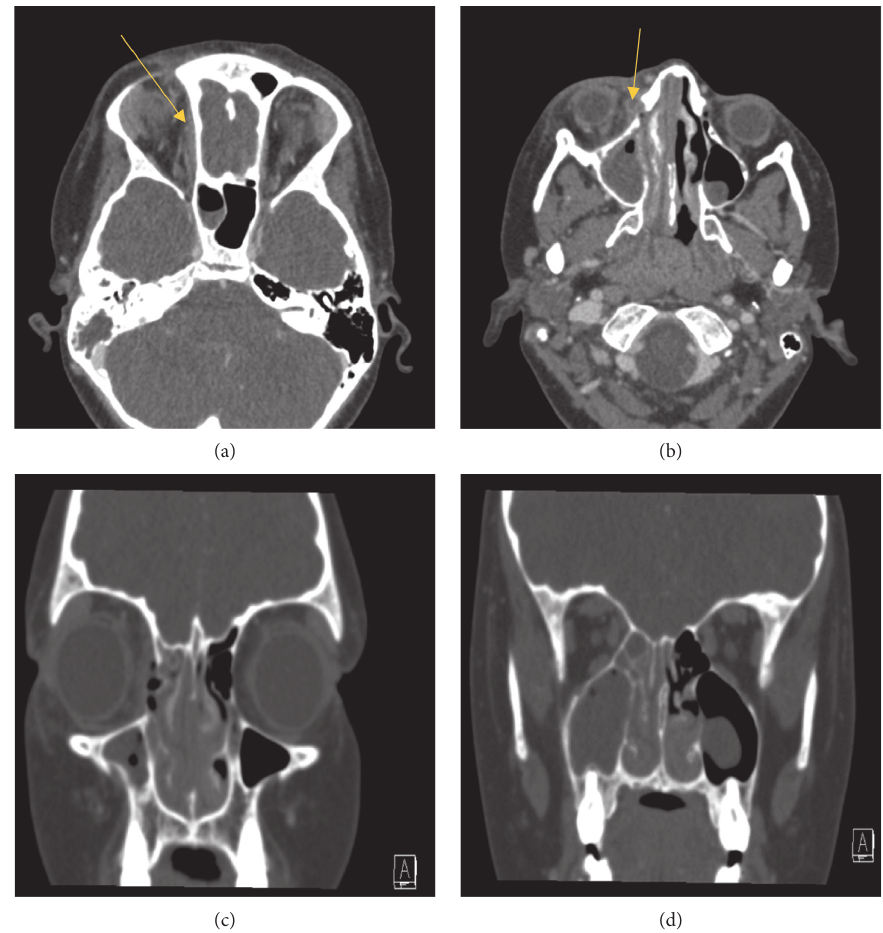
Figure 1: Computed tomography with contrast images of the presented case: (a) axial cut demonstrating a superior and medial sub- periosteal abscess (yellow arrow). (b) a smaller rim-enhancing fluid collection inferior to the abscess in A. (c) & (d) coronal sections through the paranasal sinuses with notable mucosal thickening and mucosal thickening with air-fluid levels within the right maxillary sinus, right ethmoid air cells, and right sphenoid